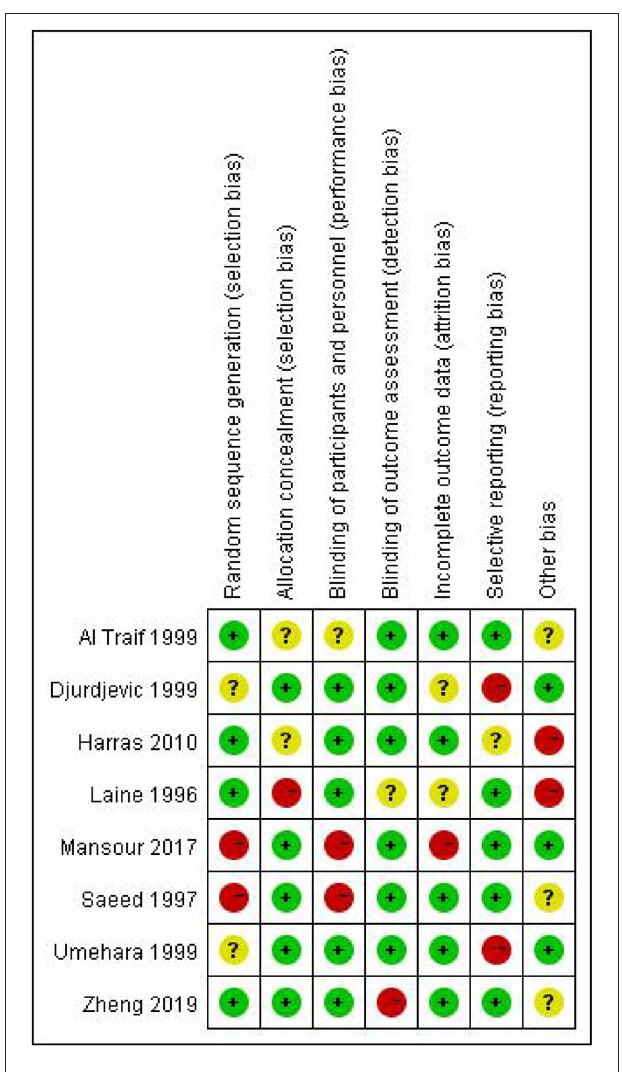
FIGURE 3 | Assessment of risk of